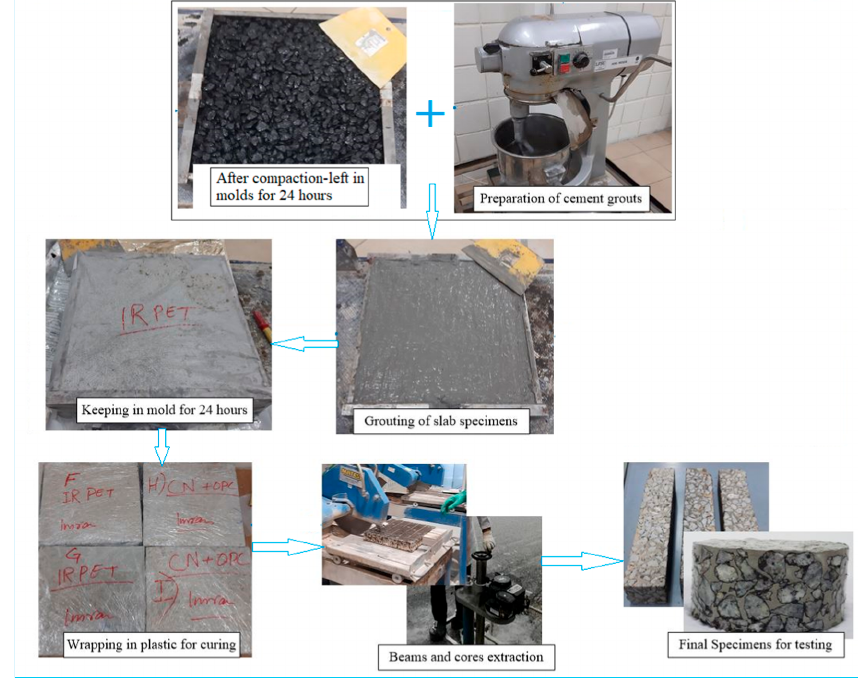
Figure 6. Pictorial representation of sample preparation [40].